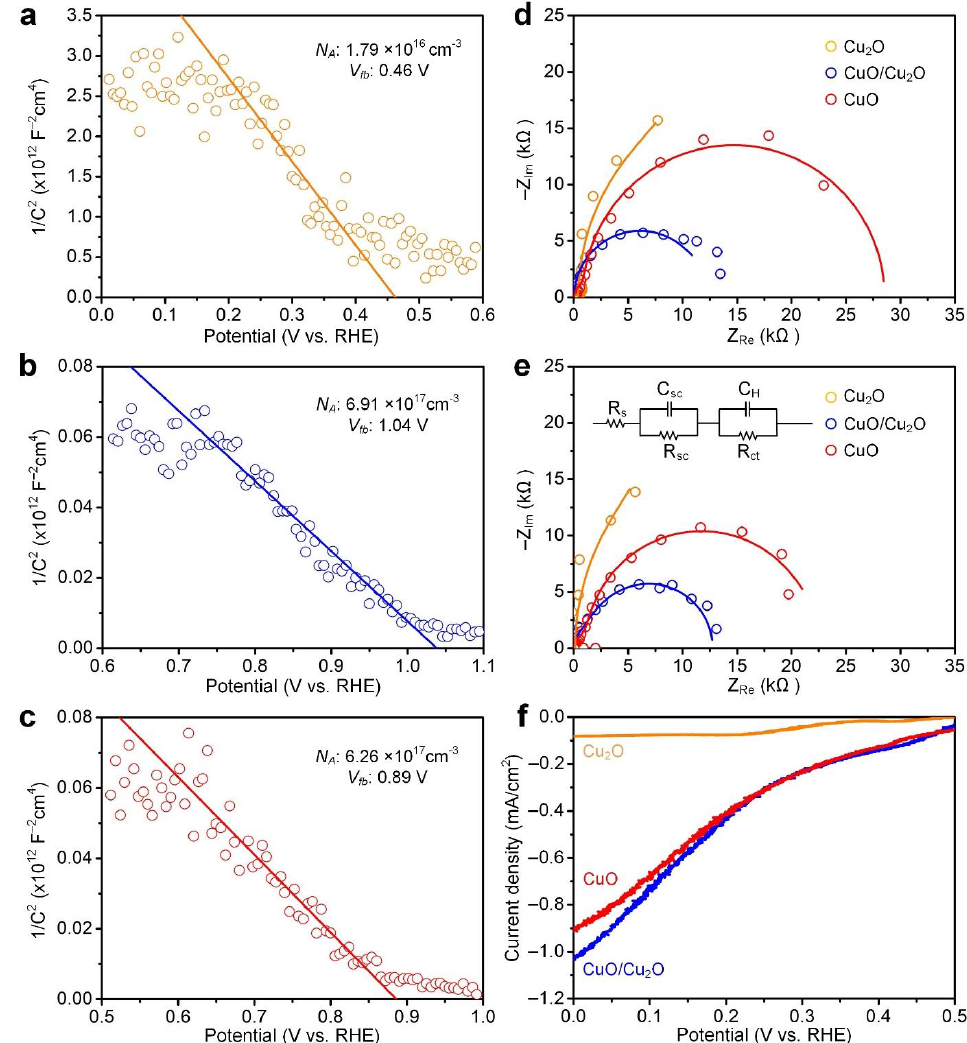
Figure 5. Mott – Schottky plots of ( a ) Cu 2 O, ( b ) CuO/Cu 2 O, and ( c ) CuO thin films and Nyquist plots of Cu 2 O, CuO/Cu 2 O, and CuO thin films without ( d ) and with ( e ) light illumination; ( f ) comparison of photocurrent densities of the three thin films. Table 1. Experimental values of carrier density ( N A ), flat band potential ( V fb ), and photocurrent den- sity for p-type Cu 2 O, CuO/Cu 2 O, and CuO thin films.